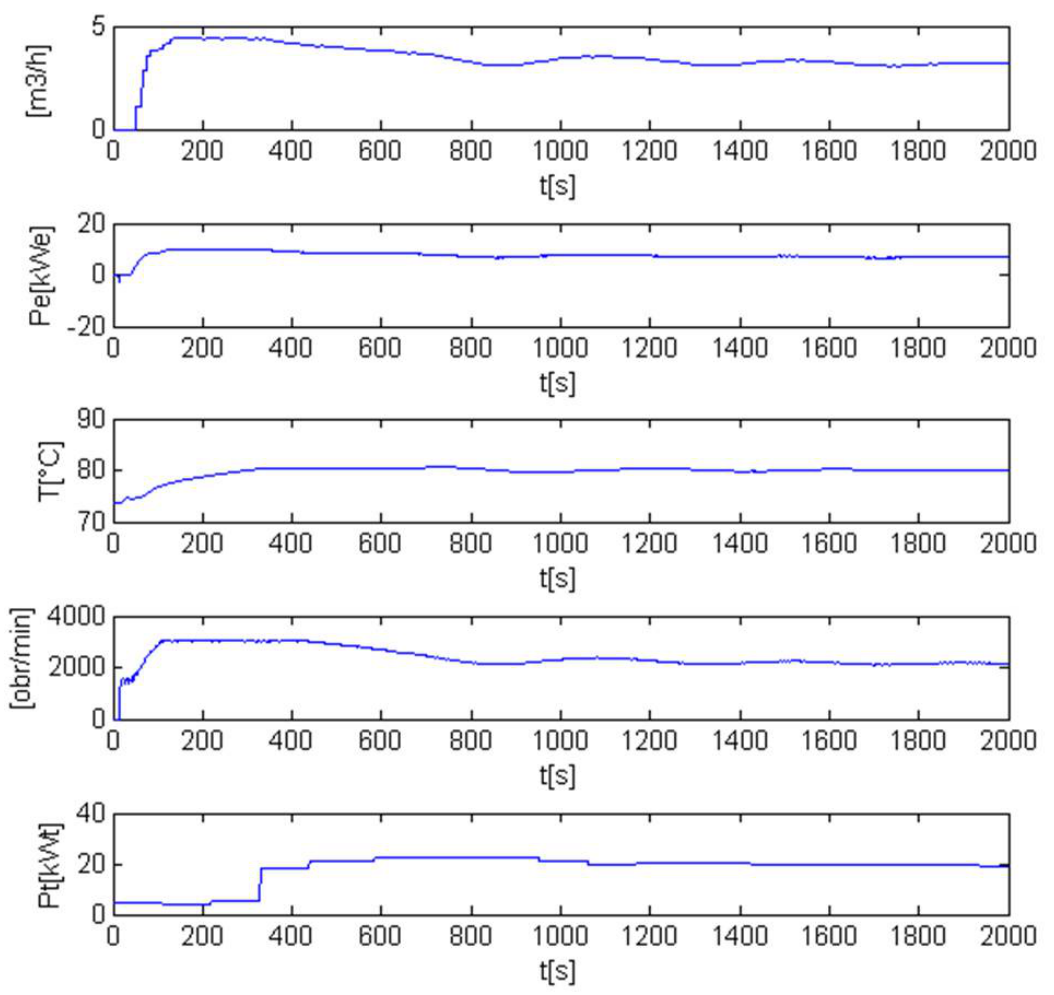
Figure 7. The course of variability of cogenerator parameters for Tref = 80 °C.